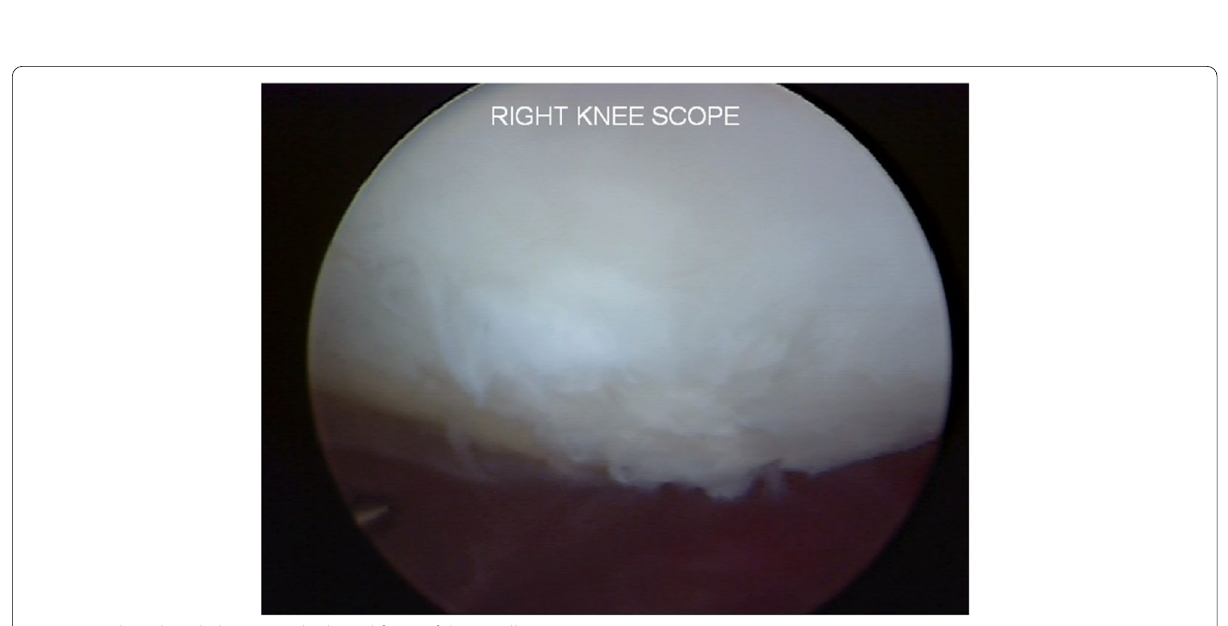
Fig. 4 Grade 2 chondral injury in the lateral facet of the